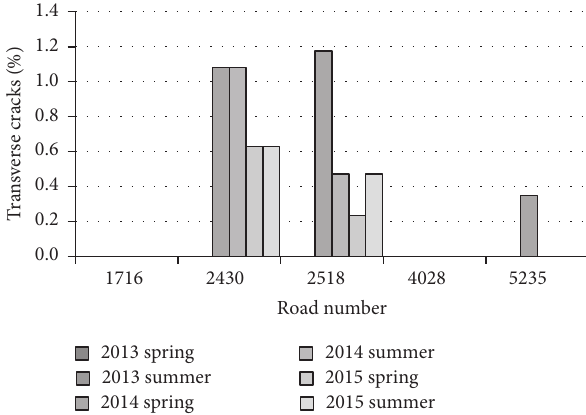
Figure 7: Transverse cracks on roads sections covered with soft asphalt.